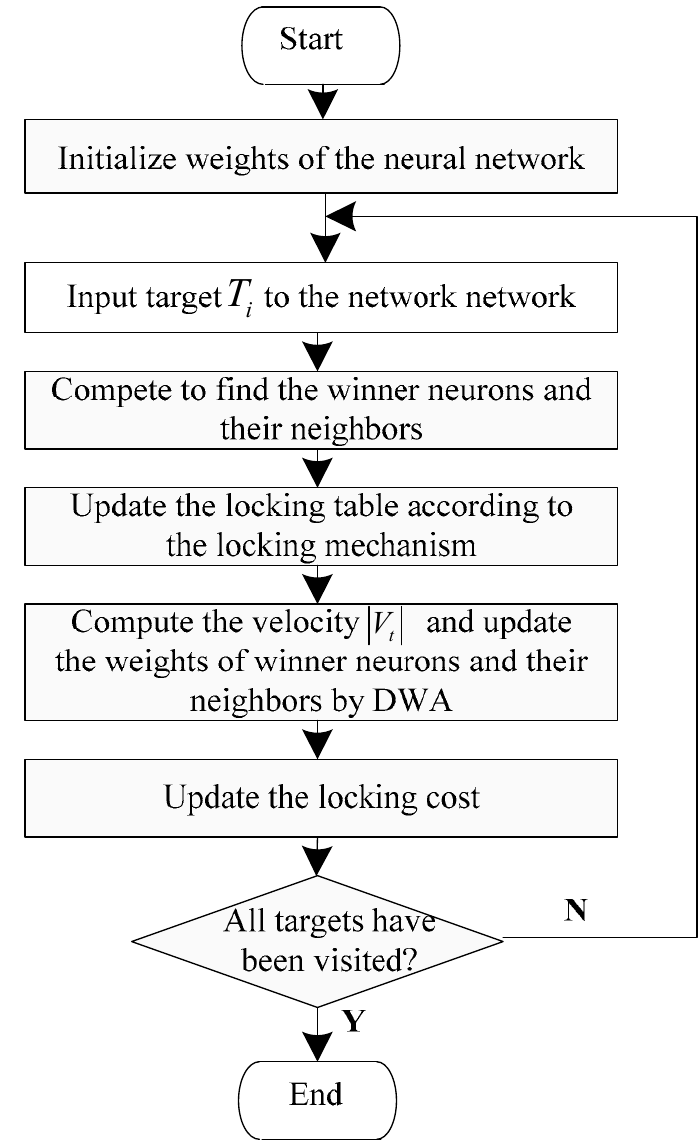
Figure 3. Flow diagram of the DSOM.